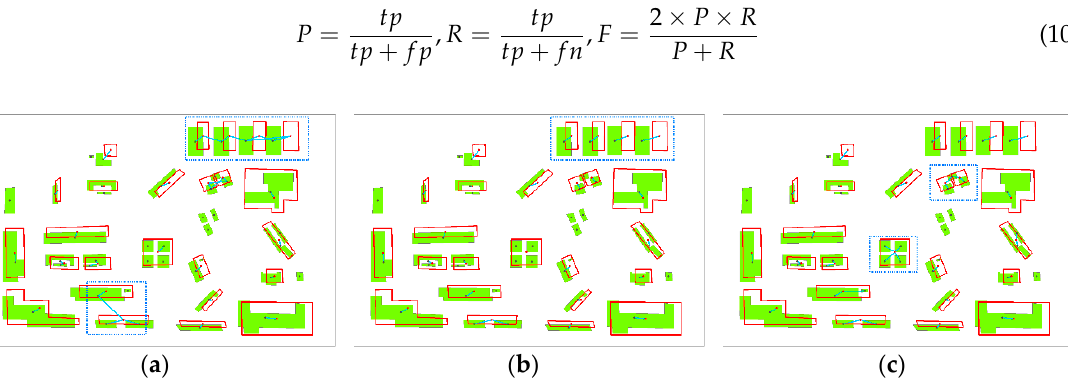
Figure 7. Matching results comparison of the mock building data: ( a ) the initial matching pairs based on local geometric similarity; ( b ) the identified matching pairs by the object-level relaxation labelling method; ( c ) the identified matching pairs by the pattern-level relaxation labelling method.